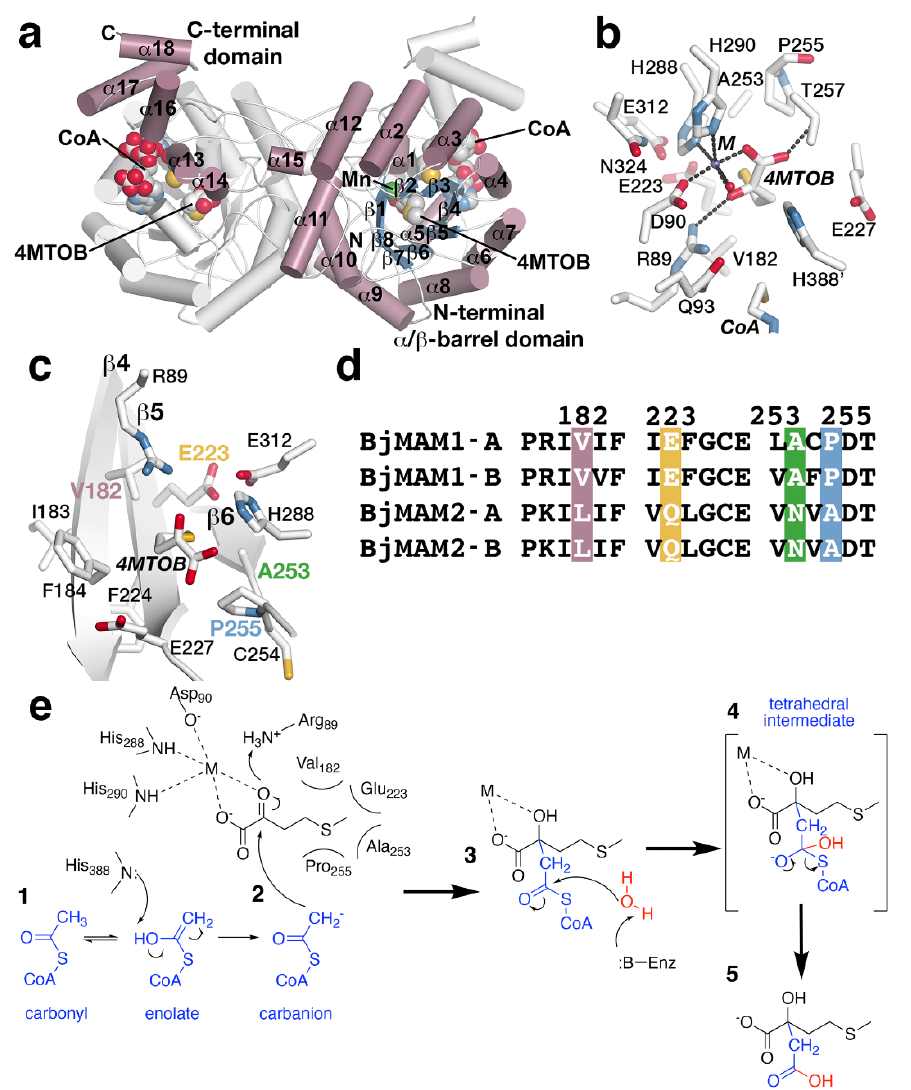
Figure 4. MAMS structure and mechanism. ( a ) Dimeric structure of B. juncea MAMS. Respective monomers are colored white and rose with secondary structure features labeled in the rose monomer. Positions of CoA and substrate 4–methylthio–2–oxobutanoic acid (4MTOB) are indicated. ( b ) Active site view showing the location of 4MTOB, divalent metal (M), and CoA. ( c ) View of the substrate binding site. This view centers of the bound 4MTOB and shows the position of the three β -strands that form the back-wall of the site. The four residues (Val182, Glu223, Ala253, and Pro255) that guide substrate preference are indicated. ( d ) Targeted sequence alignment of BjMAM1A/B and BjMAM2A/B. The four residues that dictate substrate preference are indicated. ( e ) Proposed reaction sequence of MAMS-catalyzed condensation of acetyl-CoA to a 2-oxo substrate.